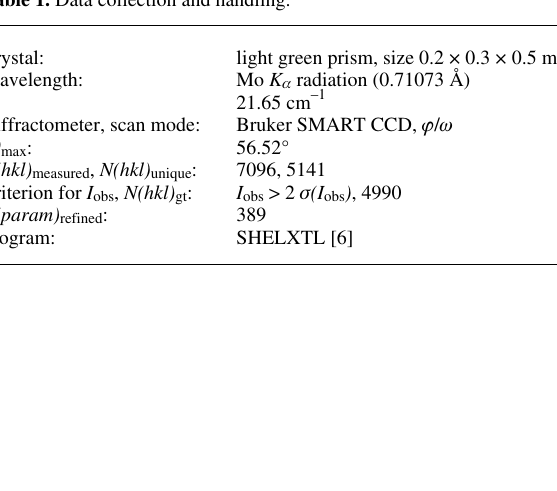
Table 2. Atomic coordinates and displacement parameters (in Å 2 ) .